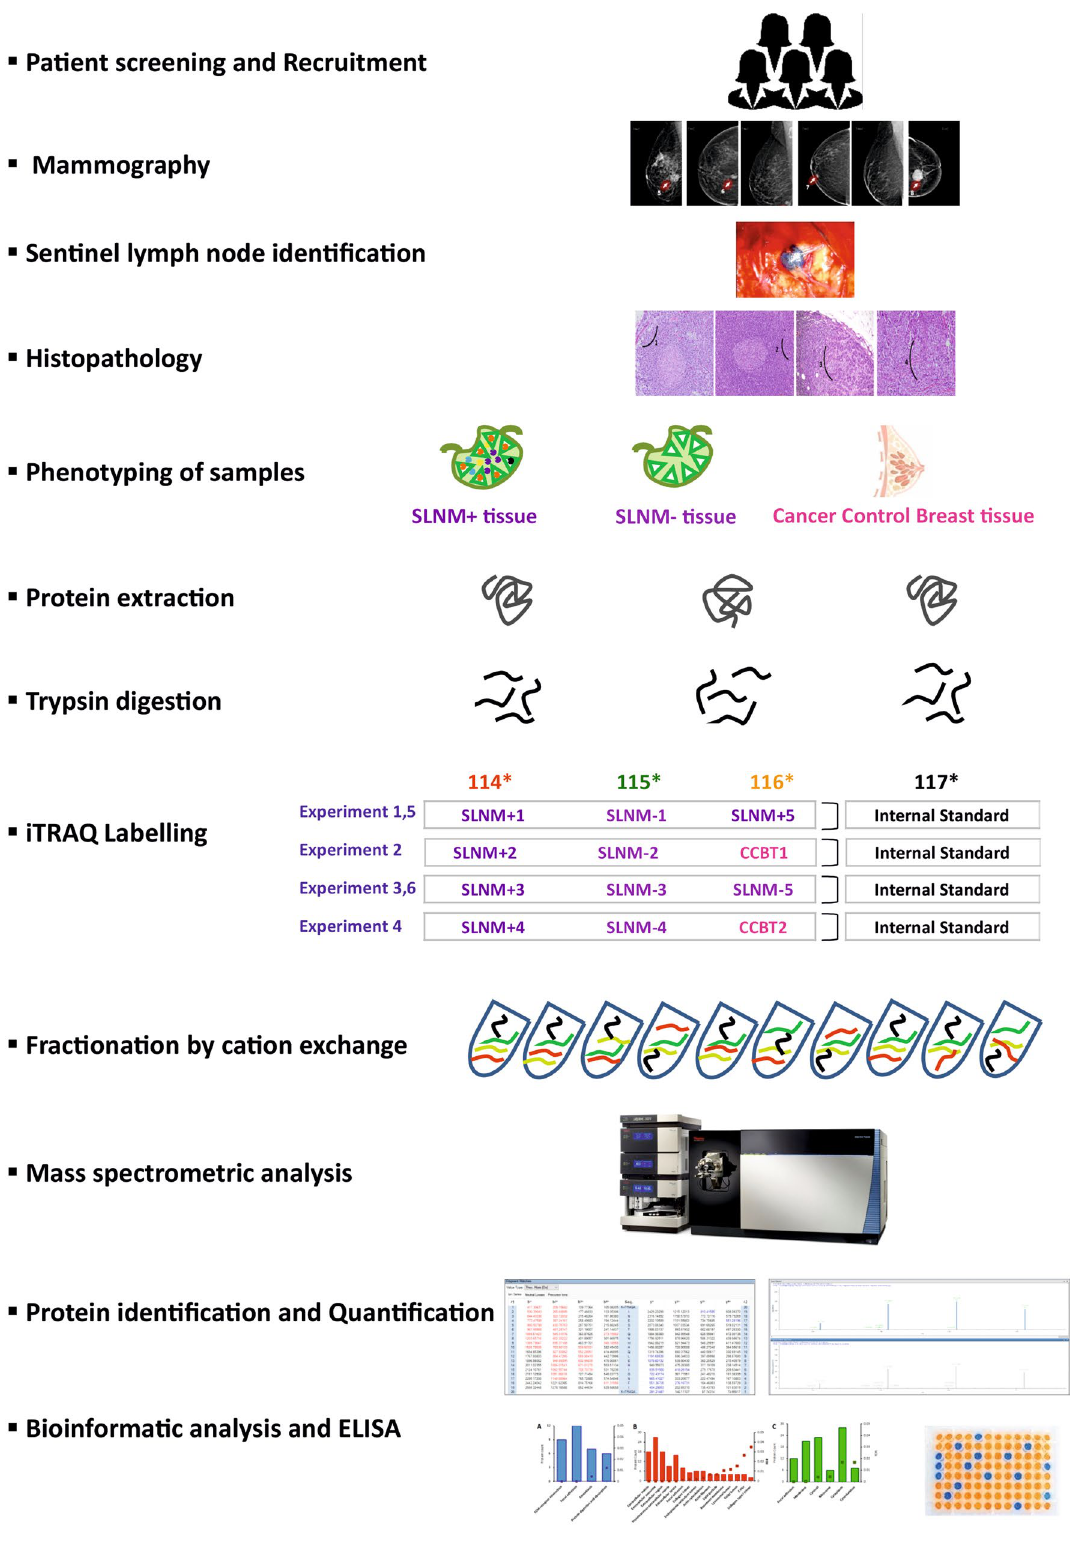
Figure 1. Flowchart depicting the methodology used in the